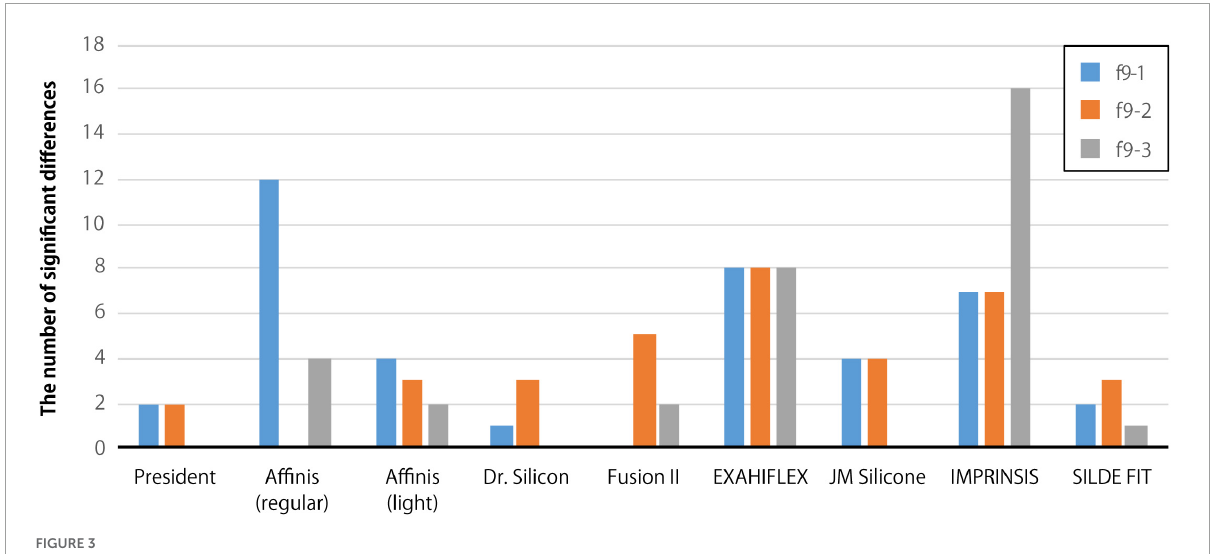
FIGURE3 The number of significant differences in 32 DMT parameters between the original tooth surface and silicone molds. Pair-wise tests were conducted for each scan location on facet 9 (f9-1, f9-2, and